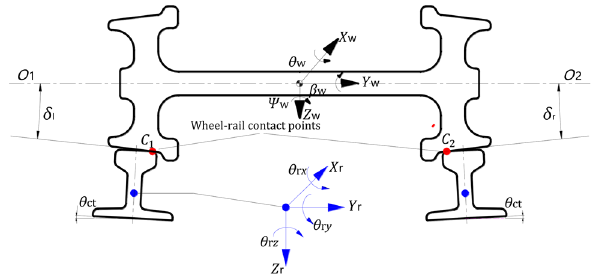
Fig. 2 Wheel–rail interaction model (the symbols d l and d r denote the wheel–rail left and right contact angle respectively; h ct denotes the rail cant, and X r , Y r , Z r , h r x , h r y and h r z denote the longitudinal displacement, the lateral displacement, the vertical displacement, the angle around X -axis, the angle around Y -axis and the angle around Z - axis of the rail centroid,